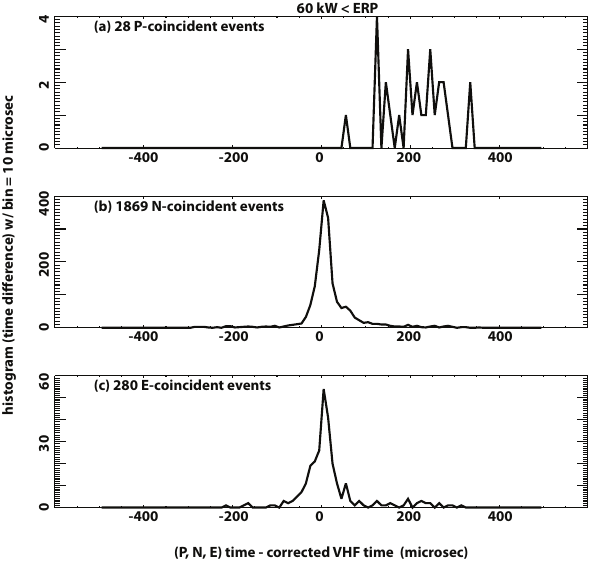
Fig. 11. Normalized distribution of the number of tight coinci- dences versus VHF ERP in the 26–49MHz passband. Each data point’s horizontal value is the median ERP within one of the eight bins of ERP of Table 3. The blue curve shows the normalized dis- tribution of VHF ERP for optical coincidences with FORTE VHF. The NLDN coincidences are in green, and the LASA coincidences are in red. Each curve is separately normalized; see Table 3 for the unnormalized data in tabular